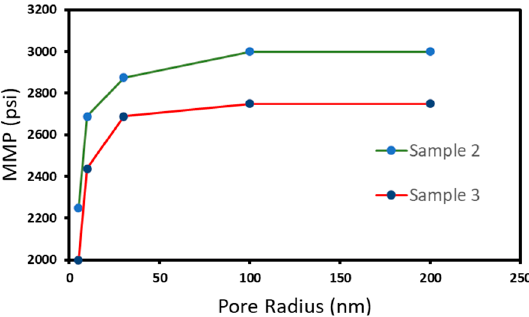
Figure 14. Minimum miscibility pressure change for Sample 2 and Sample 3 fluid with respect to pore radius.